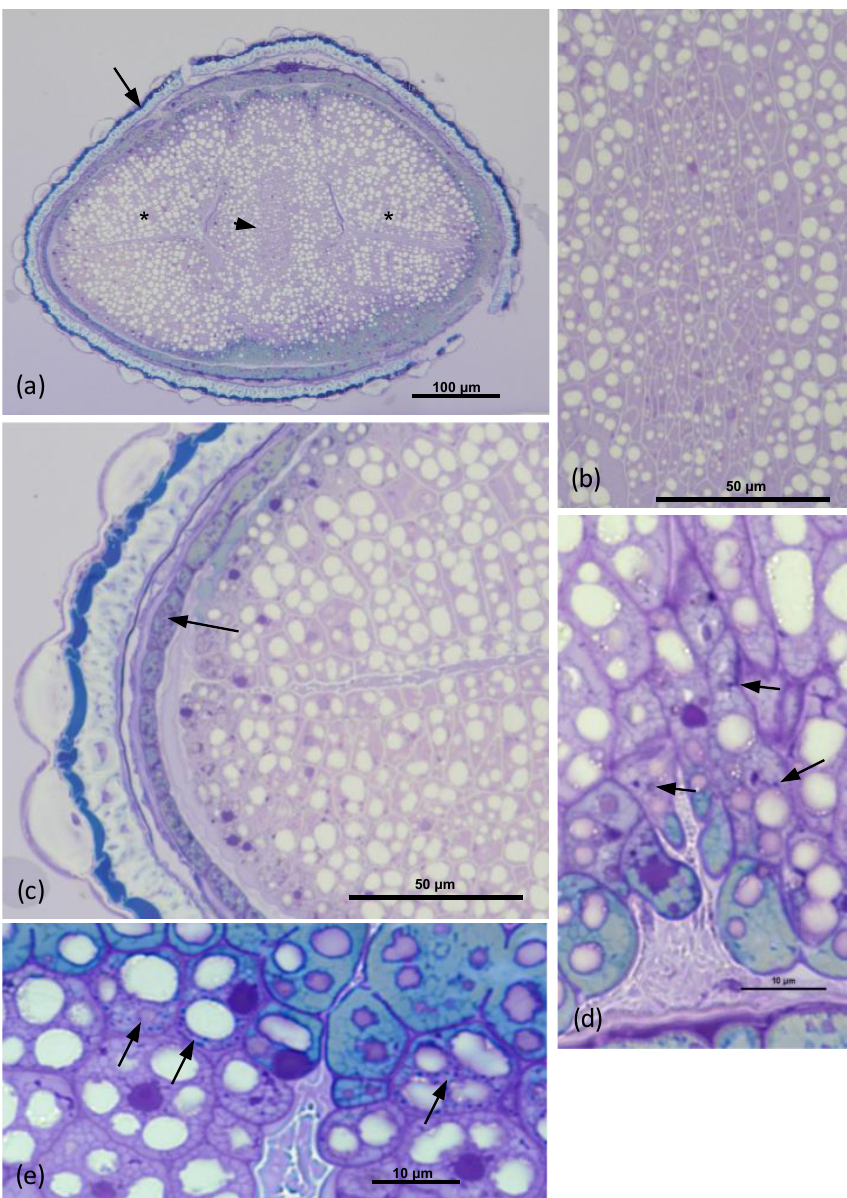
Figure 1. Toluidine blue-stained semithin cross sections of the O. heracleoticum seed. ( a ) Cross section approximately in the middle. The central axis of the embryo with the procambium (arrowhead) is in the center of the seed at this point, while the two cotyledons are on the sides (asterisks). The tegument (arrow) has a homogeneous thickness (about 20 µ m) around the seed at this point. A more external toluidine blue-positive layer surrounds sclereids. ( b ) Detail of the embryo axis. ( c ) Detail of the tegument zone. The aleurone layer (arrow) is underneath the tegument. ( d ) The cotyledon parenchyma cells close to the aleurone layer contain strongly positive toluidine dots. ( e ) The cells closest to the aleurone layer contain a large number of strongly positive toluidine dots.